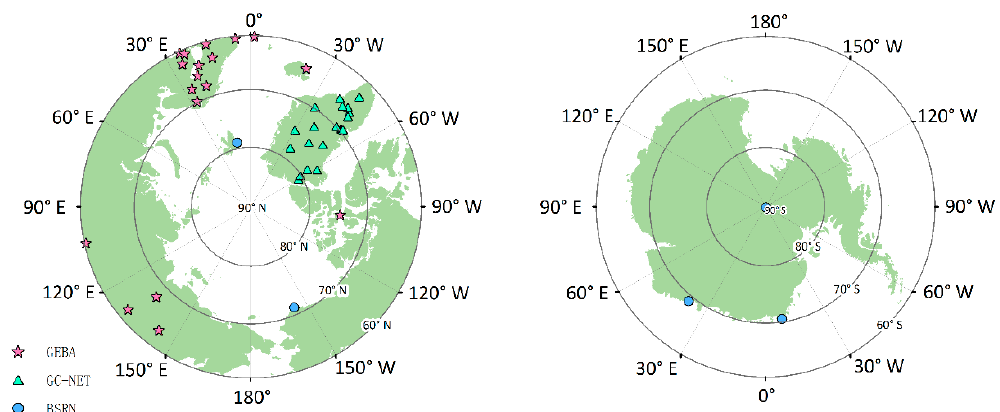
Figure 1. Geographical distributions of the observation sites (44 sites in total) used in this study from Baseline Surface Radiation Network (BSRN) (5 sites in blue dots), Greenland Climate Network (GC-NET) (21 sites in green triangles), and Global Energy Balance Archive (GEBA) (18 sites in pink